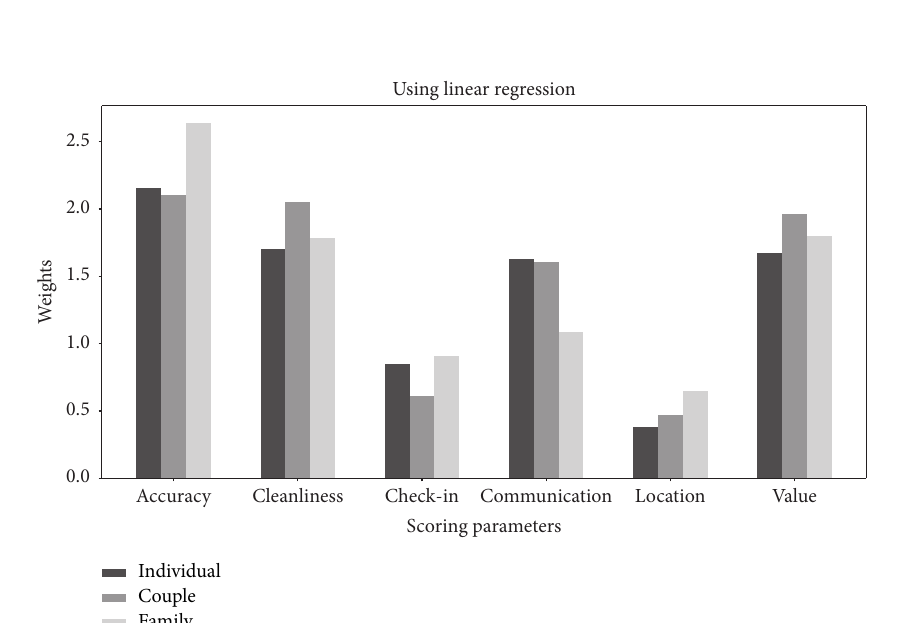
Figure 5: Distribution of coefficients calculated using the MLR algorithm.